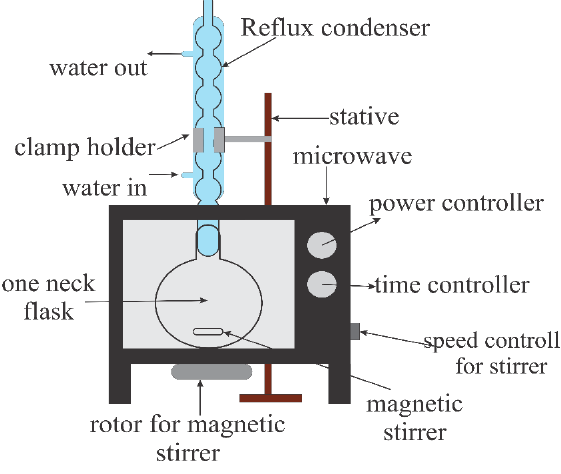
Figure 1: Schematic representation to produce biodiesel of transesterification process of nyamplung ( Calophyllum inophyllum L.) oil with CaO catalyst from eggshells waste by using microwave. Table 1: Levels of independent variables used for